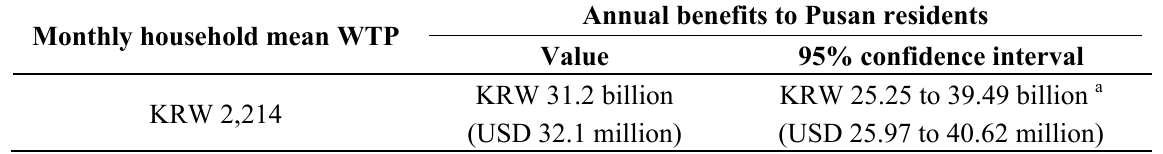
Table 5. Annual willingness to pay (WTP) of tap water quality improvement in Pusan, Korea. Monthly household mean